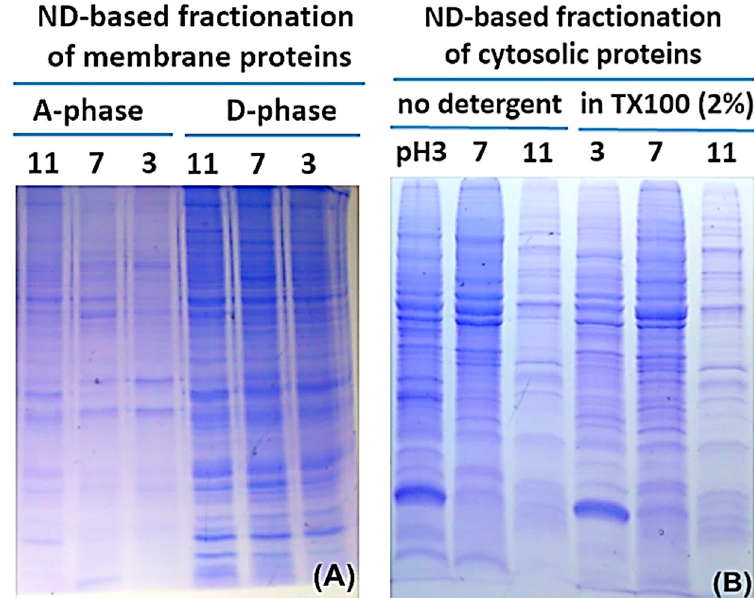
Figure 2. Sequential pH-tuned fractionation and separation of proteins based on SPE with ND: ( A ) fractionation of membrane proteins (MP) enriched sample following cloud point extraction; and ( B ) fractionation of corresponding MP-depleted cytosolic proteins. The input samples used were membranous pellet and cytosolic supernatant, respectively, harvested from ultracentrifugation of mouse myeloma cell lysate. ( A ) For MP, they were first enriched from the membranous pellet with TX-100 two-phase separation and the proteins in the detergent phase (D-phase) are fractionated by sequential pH-tuned extractions with NDs; ( B ) For comparison purposes, the cytosolic supernatant was prepared in two different buffers, with and without the addition of detergents, to test the influence of the surfactant on protein extraction.